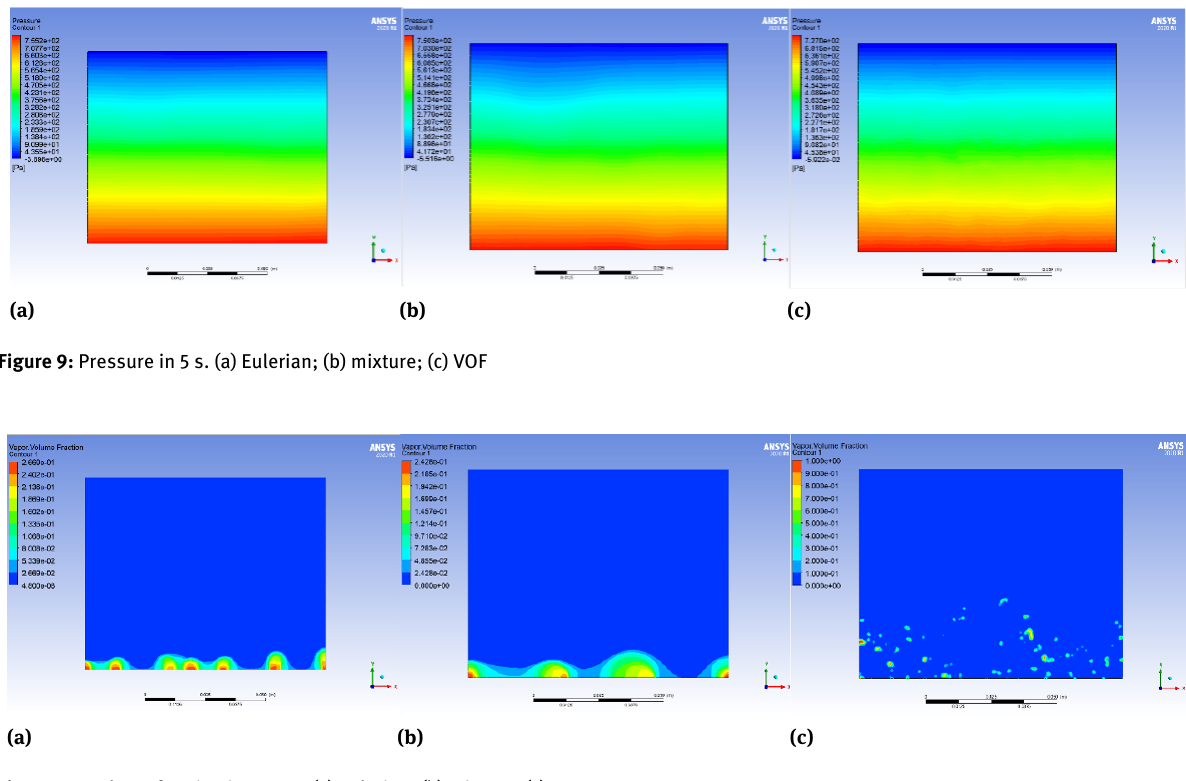
Figure 10: Volume fraction in 0.65 s. (a) Eulerian; (b) mixture; (c)